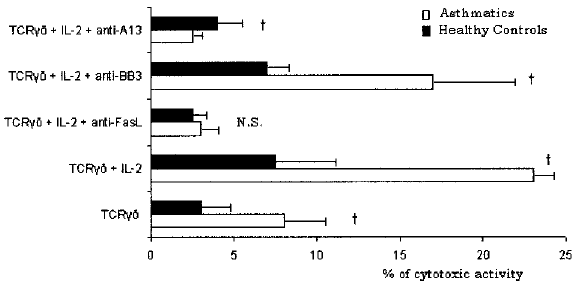
FIG. 4. Cytotoxic activity mediated by TCR gd + cells against K562 target cells. TCR gd + cells were purified from induced sputum from asthmatic patients and from healthy controls. The values represent the mean of triplicate assays at a 10:1 (E:T) ratio.† Cytotoxic activity of asthmatics was significantly different from healthy controls ( p < 0.001); N.S., not sig- nificantly